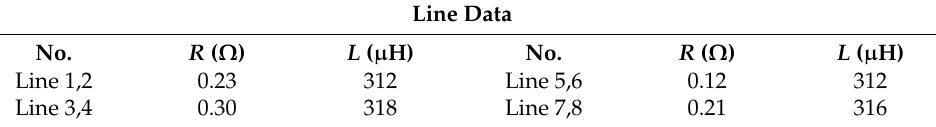
Table A3. Line data used in the test system.